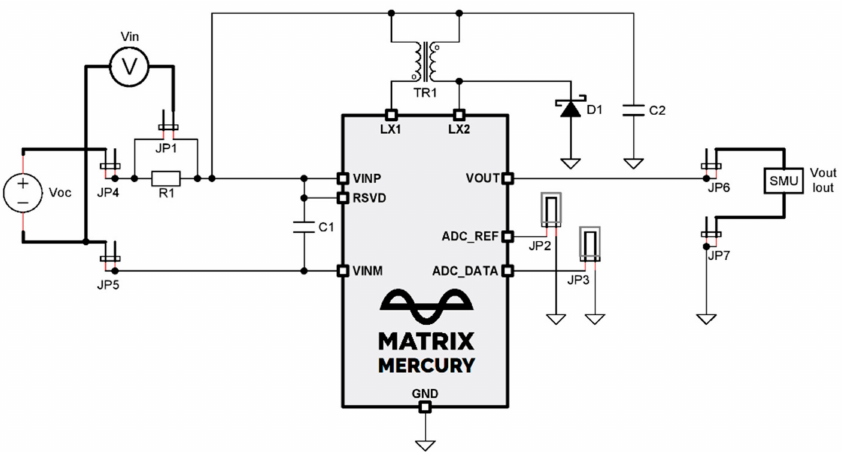
Figure 6. Measurement setup for the e ffi ciency measurements.